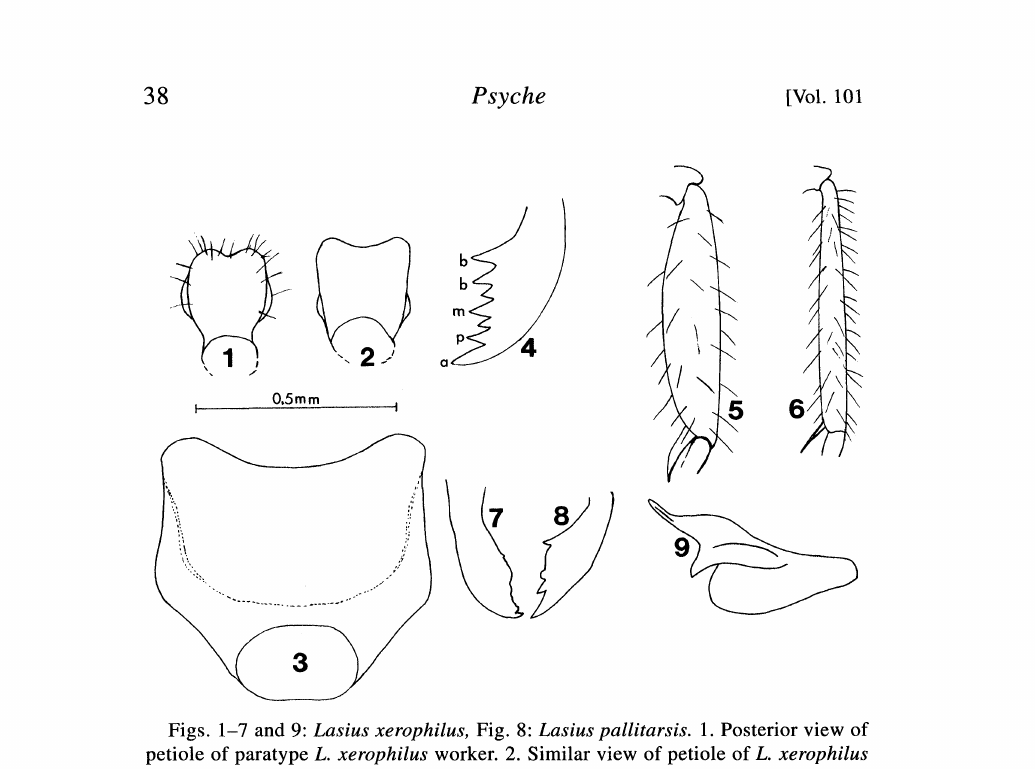
Figs. 1-7 and 9: Lasius xerophilus, Fig. 8: Lasius pallitarsis. 1. Posterior view of petiole of paratype L. xerophilus worker. 2. Similar view of petiole of L. xerophilus male paratype. 3. Similar view of petiole of paratype female L. xerophilus. 4. Left mandible of L. xerophilus paratype worker, b basal, m median, p preapical and a apical. 5. Anterior view of front tibia of paratype L. xerophilus worker. 6. Similar view of posterior tibia of L. xerophilus paratype worker. 7. Right mandible of paratype male L. xerophilus. 8. Left mandible of Lasius pallitarsis male (NM, Los Alamos Co., 8 KN Los Alamos). 9. Right aedeagus (outer surface) of male paratype L.